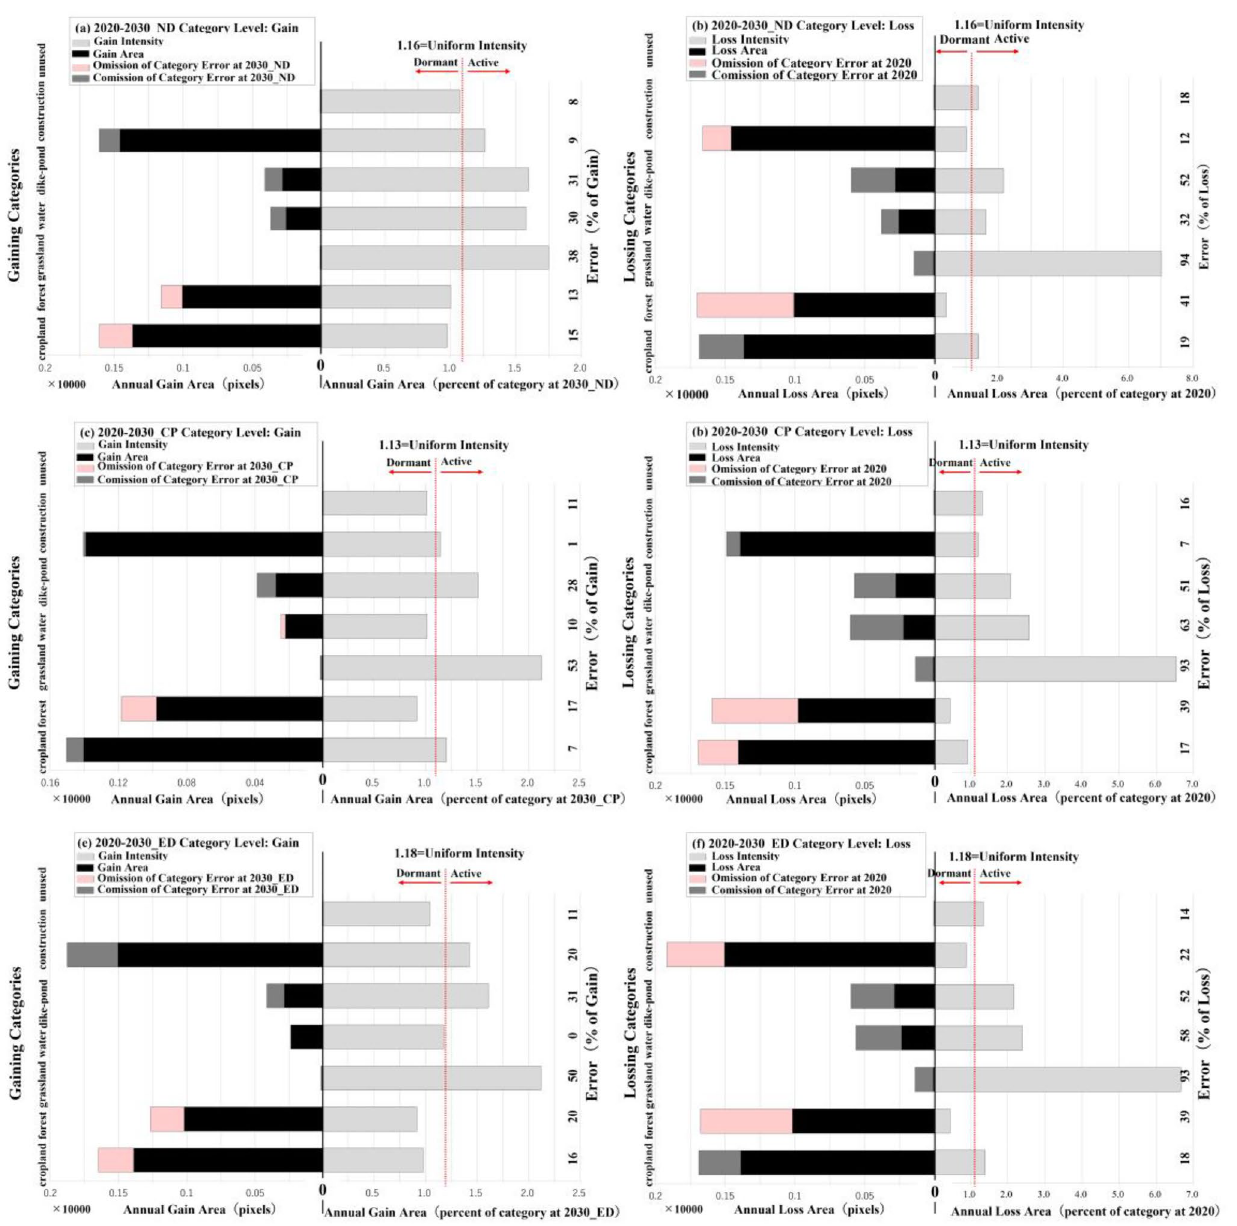
Fig.13 Category level of three simulation scenarios from 2020 to